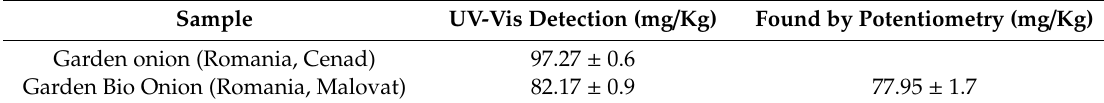
Table 2. Determination of bromide in garden onion